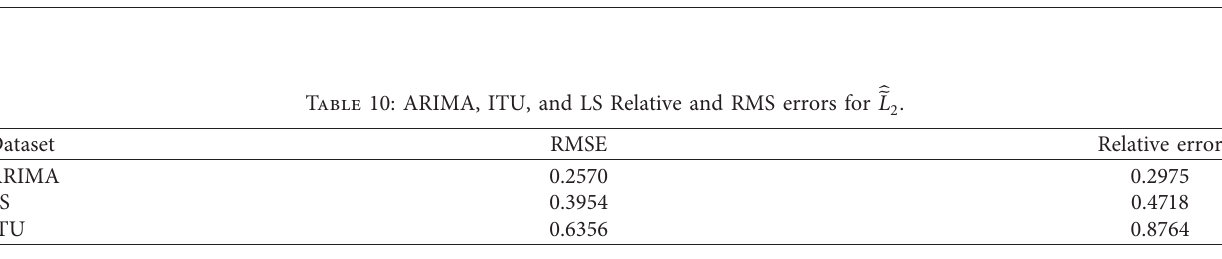
Table 10: ARIMA, ITU, and LS Relative and RMS errors for 􏽢􏽥 L